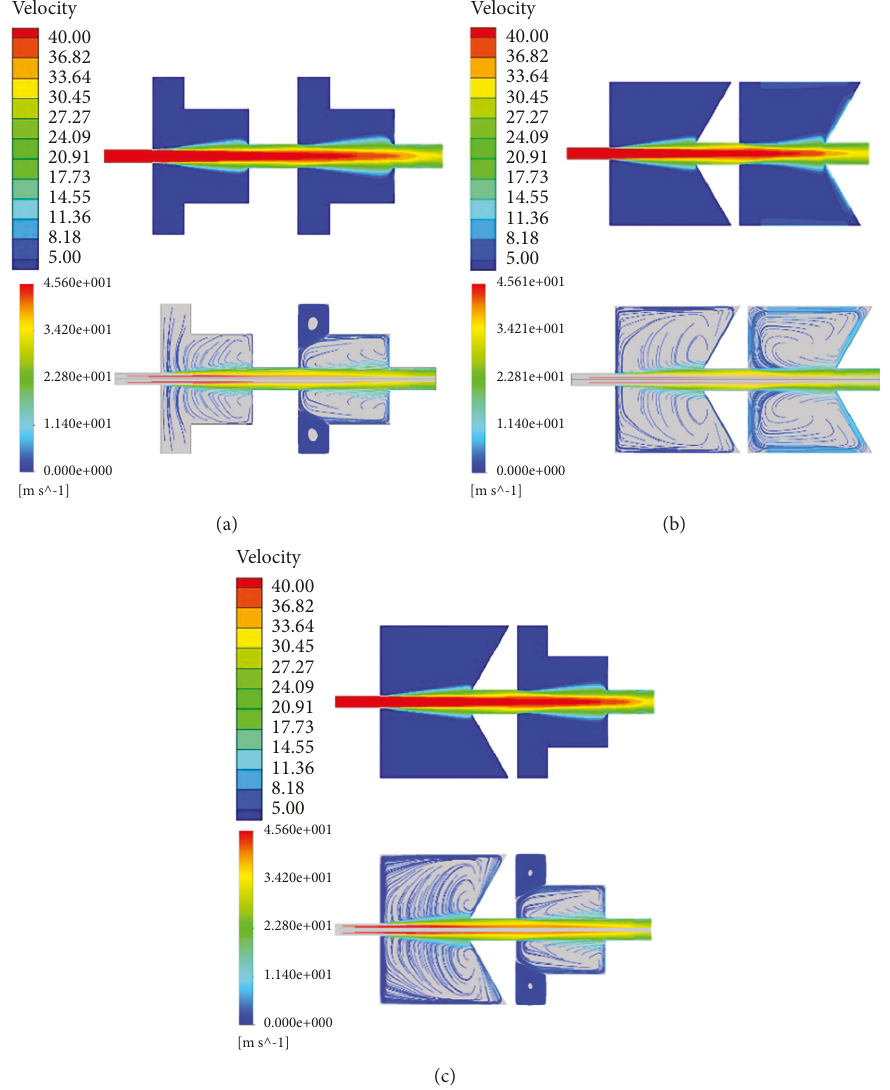
Figure 10: Cloud images of velocity distribution and streamlines of dual-chamber self-excited oscillating pulsed nozzles. (a) Organ pipe +organ pipe, (b) Helmholtz+Helmholtz, and (c) Helmholtz+organ